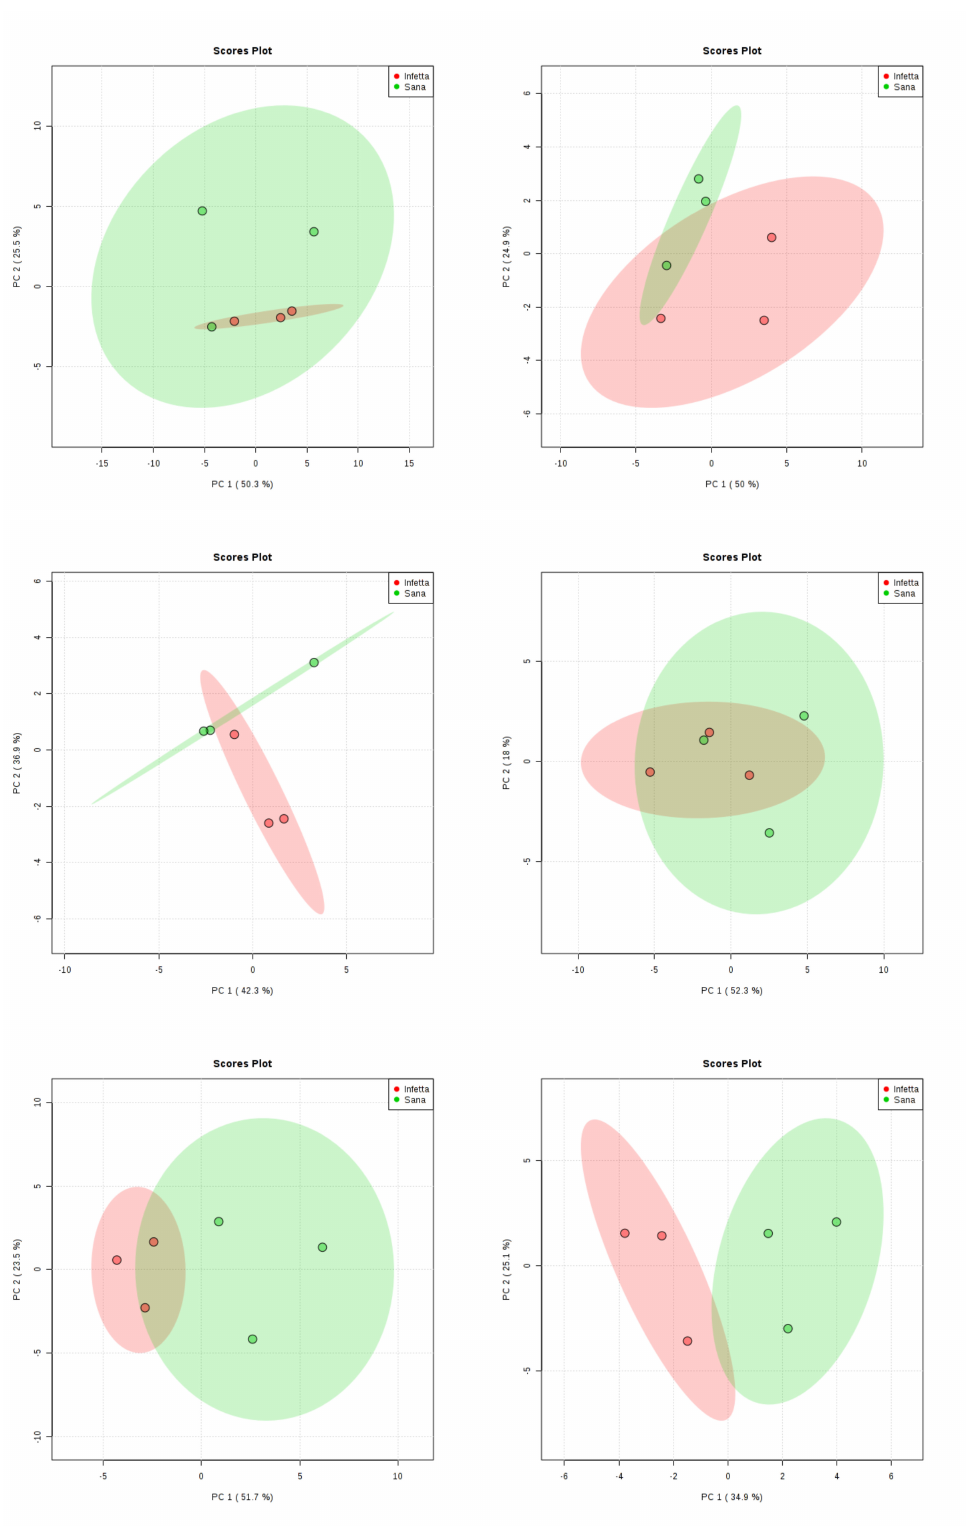
Figure 3. Principal component analysis applied to volatiles emission data obtained from pine processionary moth-infested (red circles) or not infested (green circles) pine needles collected in Bova (left) or in Canolo (right) during six samplings along the insect biological